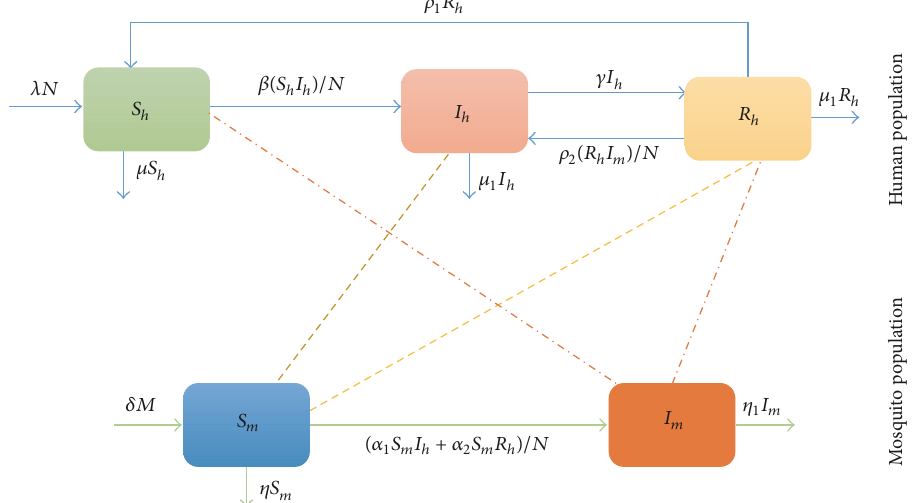
Figure 2: Schematic representation of the mosquito-human malaria transmission